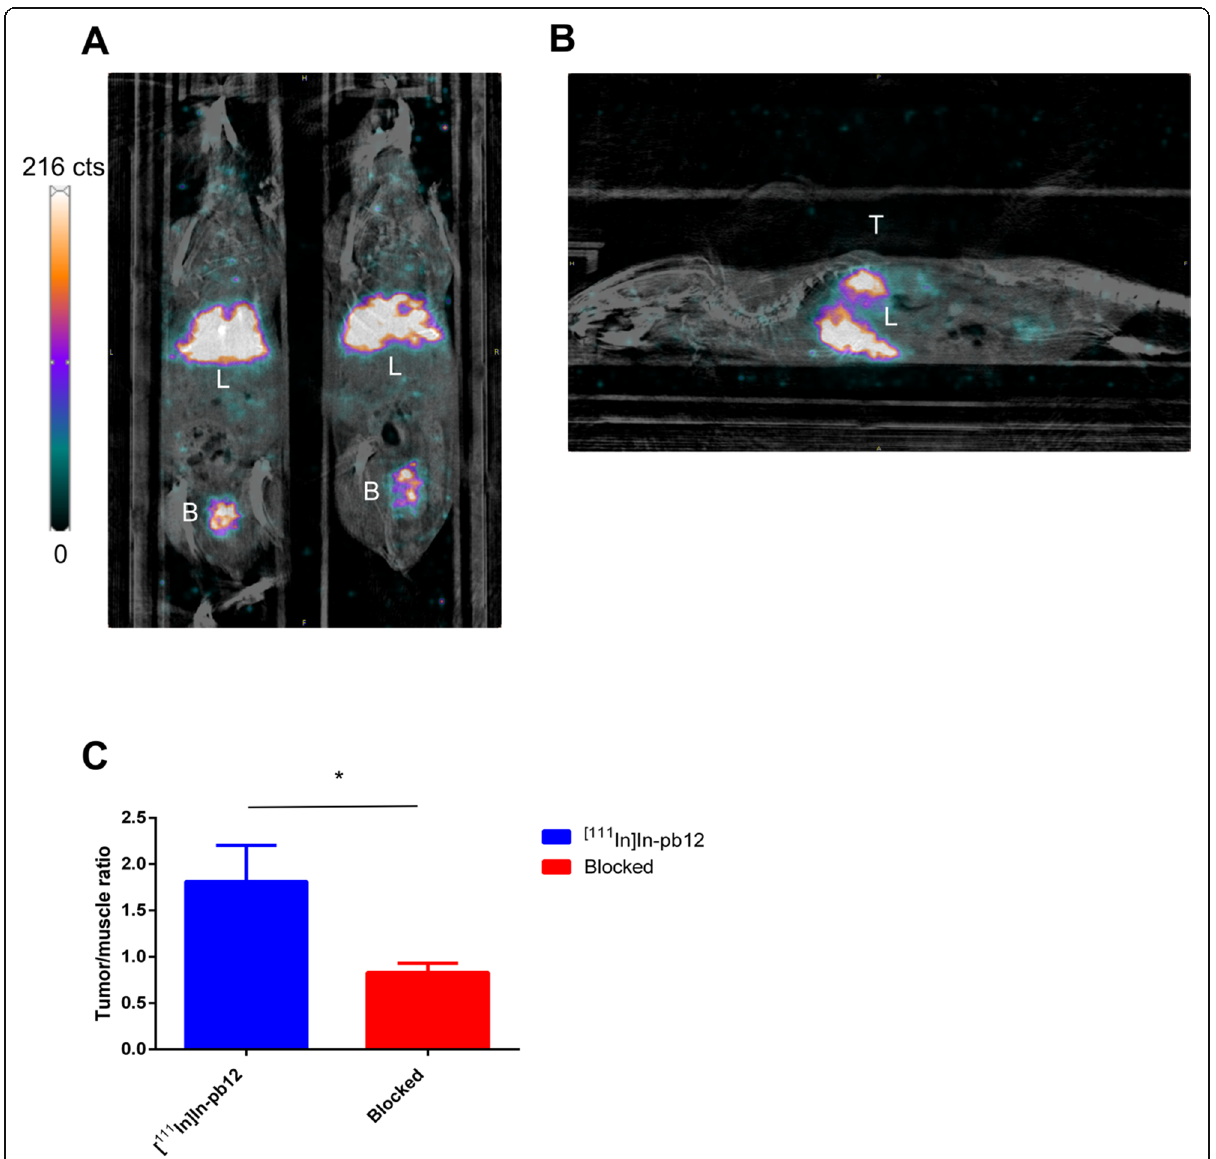
Fig. 7 In vivo behavior of [ 111 In]In-pb12 in MCF-7 xenograft mice. a Representative SPECT/CT coronal image at 12 min post-injection showing major elimination of [ 111 In]In-pb12 by the liver and minor elimination by the bladder. b Representative SPECT/CT sagittal image at 12 min post- injection showing major elimination of [ 111 In]In-pb12 by the liver. c Tumor/muscle ratio at 12 min post-injection of [ 111 In]In-pb12 in MCF-7 xenografted mice determined on the SPECT/CT images. Co-injection of non-labeled pb12 (blocked group) significantly decreases the tumor/ muscle ratio. L stands for liver, B means bladder and T stands for MCF-7